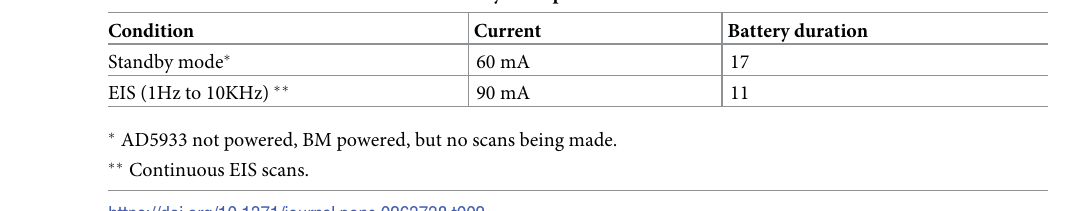
Table 2. Current draw of TBISTAT for standby and operation